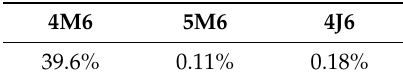
Table 1. Percentage of inhibition of bacterial biofilms in the presence of DBHB (16 µ